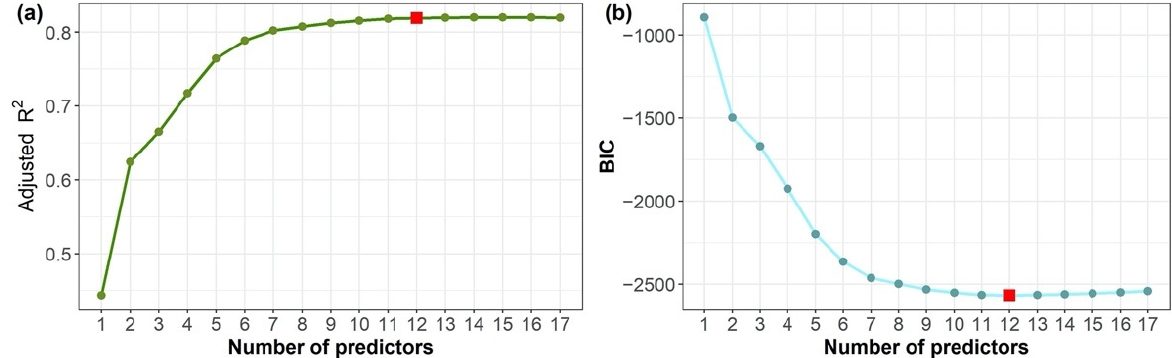
Figure 10. ( a ) Adjusted R 2 and ( b ) BIC vs. the number of predictors obtained by the best subset selection method.